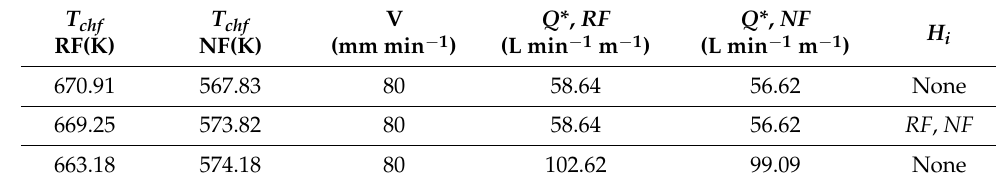
Figure 14. Variations of boiling curves, CHF and 𝑇 (cid:3030)(cid:3035)(cid:3033) with different 𝑇 (cid:3036) and 𝑄 ∗ by DC secondary cooling simulator tests: ( a ) boiling curve with different 𝑇 (cid:3036) at 473, 523, 573, 623, 673 K, respectively, and the same 𝑄 ∗ at 60 L min − 1 m − 1 ; ( b ) boiling curve with different 𝑄 ∗ at 20, 40, 60, 80, 100 L min − 1 m − 1 and the same 𝑇 (cid:3036) at 673 K; ( c ) the variations of 𝑇 (cid:3030)(cid:3035)(cid:3033) at different 𝑇 (cid:3036) ; ( d ) the variations of 𝑇 (cid:3030)(cid:3035)(cid:3033) at different 𝑄 ∗ .